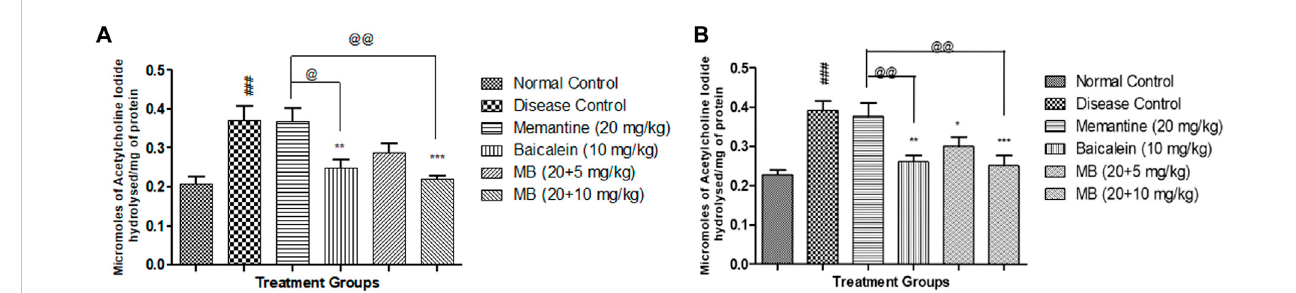
FIGURE 2 EffectsofbaicaleinandbaicaleinwithmemantineonAChEActivity (A) . Hippocampus , (B) .Cortex.Dataareexpressedasmean±SEM( n =6),with### p <